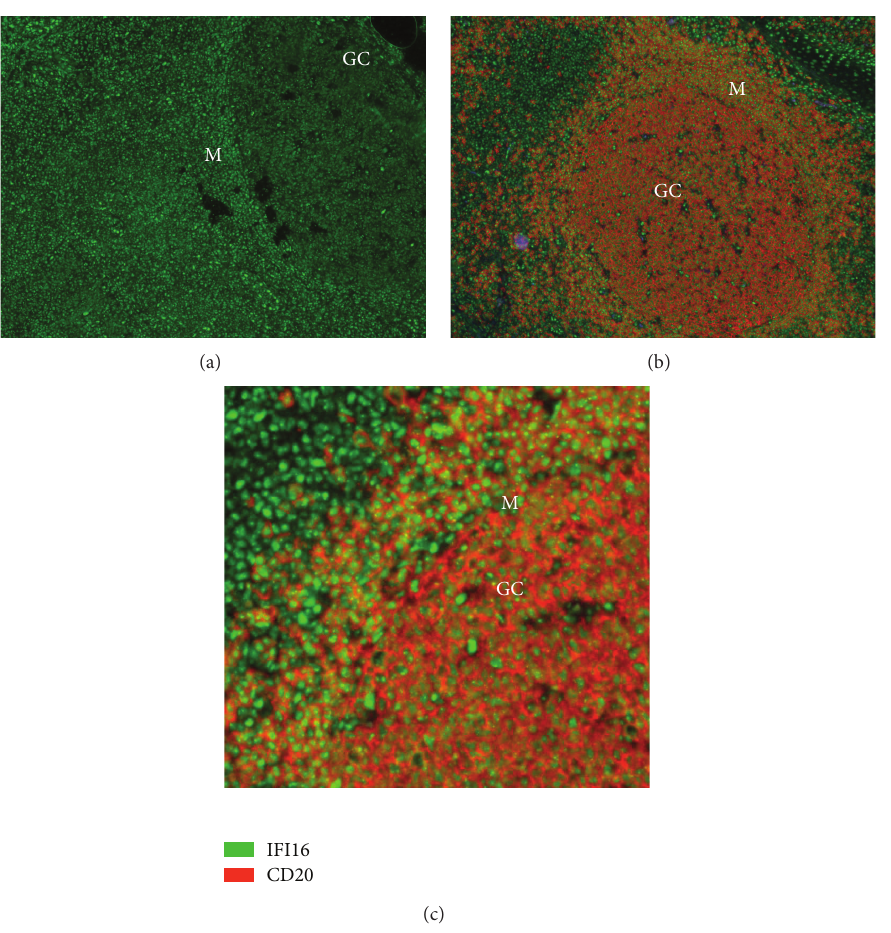
Figure 2: IFI16 protein expression in normal lymphoid tissues . (a) IFI16 staining of GC and mantle zones. (b) Double staining with CD20 and IFI16 antibodies. IFI16 protein expression in reactive lymphoid follicles; the expression pattern was largely restricted to B-lymphocytes of the mantle zone (M) and germinal centers (GC). (c) Particular of panel (b). Higher fluorescence in B-cells of the mantle zone (M) indicates a higher expression in this compartment compared with GC cells. These micrographs were obtained using an Olympus BX61 microscope equipped with an Olympus DP70 digital camera (magnification 100–400x); image acquisition, evaluation, and color balance were performed with Cell ∧ F